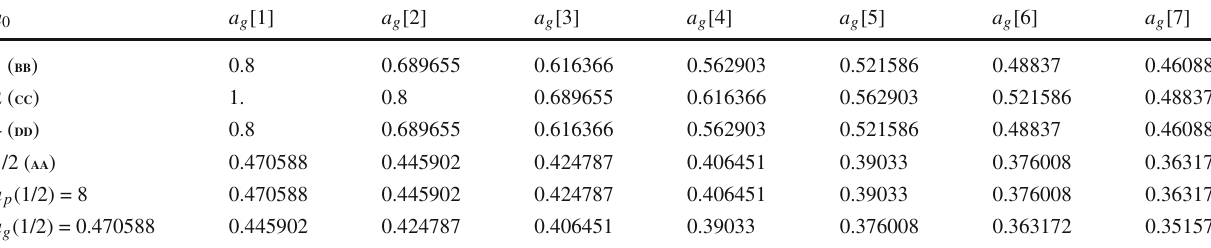
BC bundles are also shown. Cycles (with the exclusion of the initial point a 0 ) are entirely confined in the BH region. Models XX where X = { A , B , C , D } are defined in Fig. 15